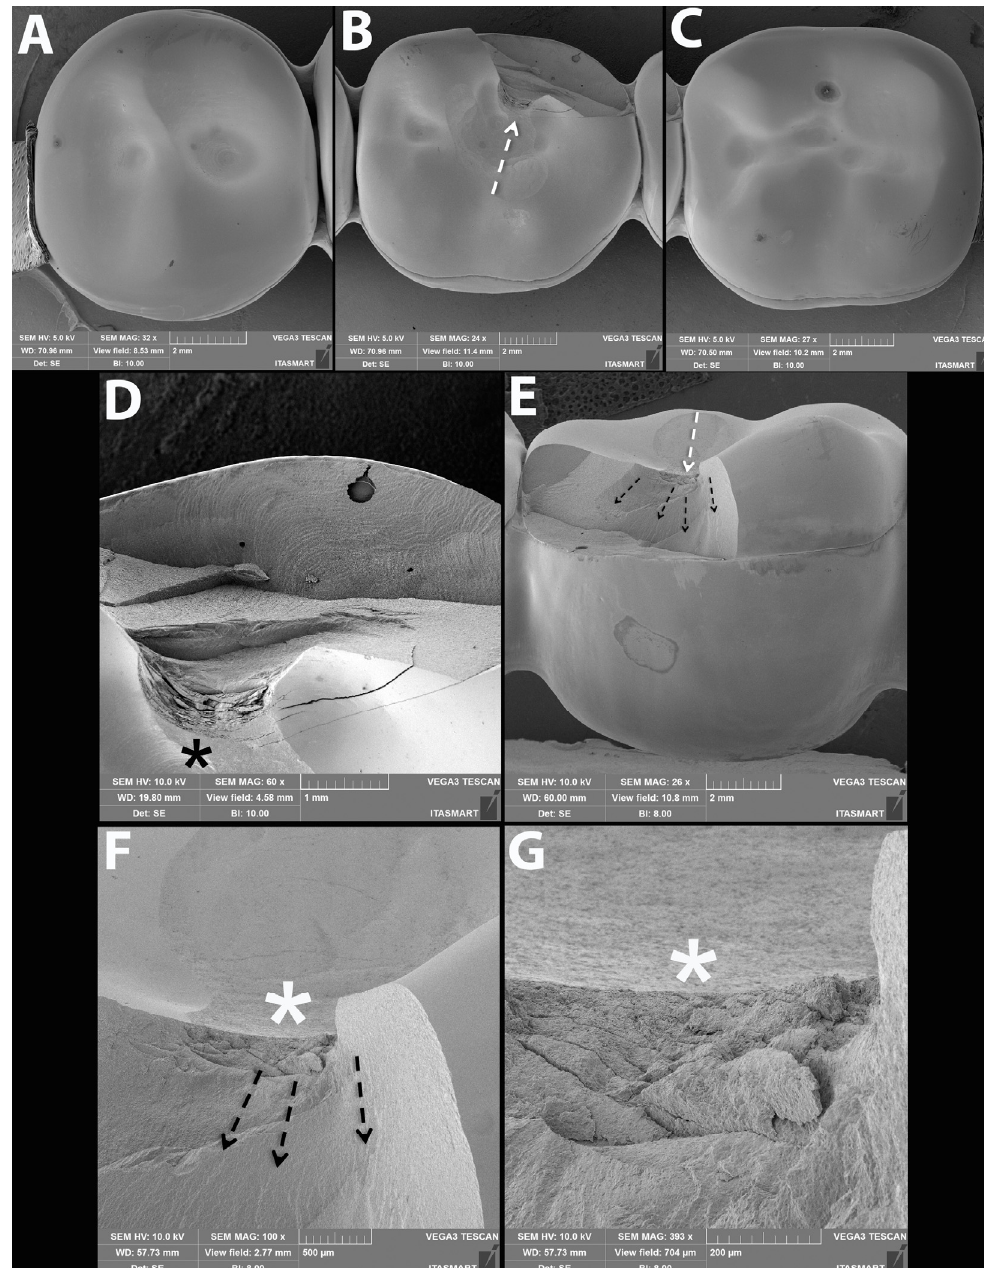
Figure 9. Representative SEM micrographs of fractured FDP from Group RL. Occlusal views of abutments ( A , C ) and of fatigued pontic ( B ) with indenter sliding path (dotted white arrow) leading to discrete wear of the PICN tabletop bonded to the zirconia framework. ( D ) Magnified view of the fracture origin at the occlusal surface (asterisk) and ( E ) buccal view showing the origin (dotted white arrow) and direction of crack propagation (dotted black arrows) within the PICN material halted at the interface with the zirconia framework. ( F , G ) are magnified views of E where the dotted arrows of ( F ) point at the hackle lines indicating the direction of crack propagation towards the zirconia framework and ( G ) shows damage from loading at the occlusal region (asterisk).